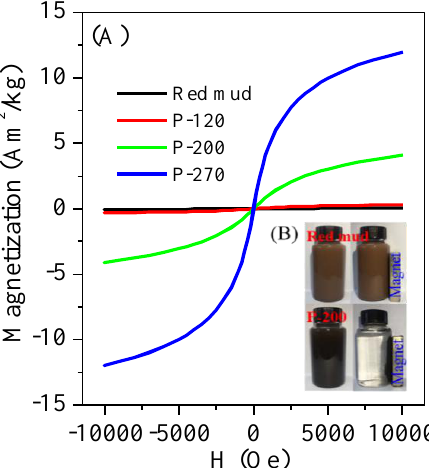
Figure 2. Magnetic hysteresis curves of red mud, P-120, P-200, and P-270.